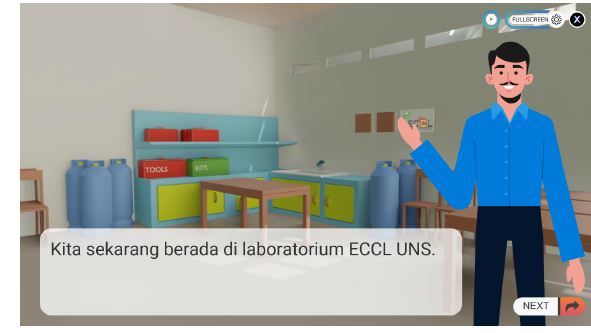
Figure 2: The virtual laboratory home screen